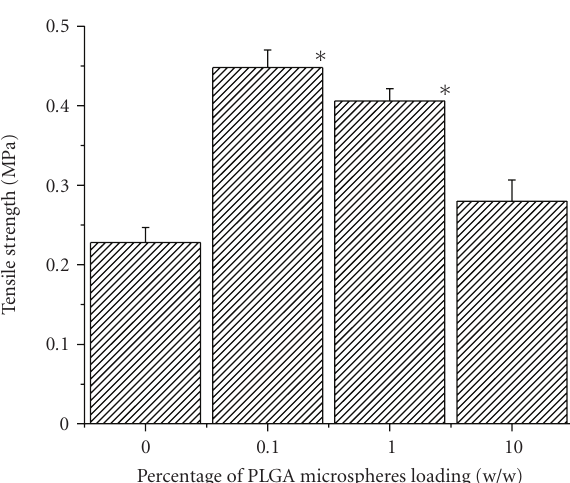
Figure 4: E ff ect of PLGA microsphere incorporation on the swelling property of gelatin sca ff old. Values are mean ± S.D. ( n = 3). ∗ P < . 005, compared to gelatin sca ff old having no PLGA microsphere.